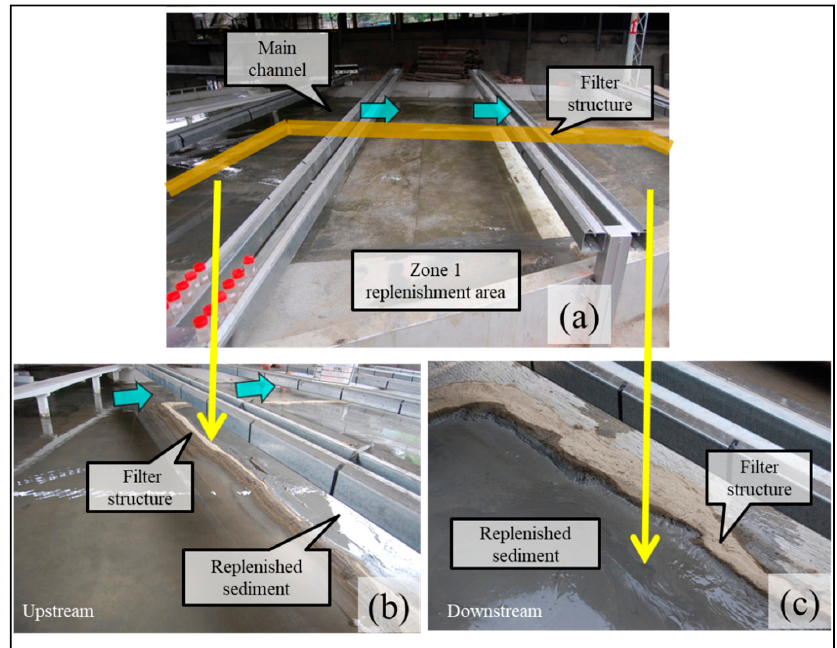
Figure 9. Installation of replenished sediment and filter structure (serving as a permeable barrier): ( a ) Zone 1 in the physical model, ( b ) view from the upstream side, and ( c ) view from the downstream side of the replenishment area.